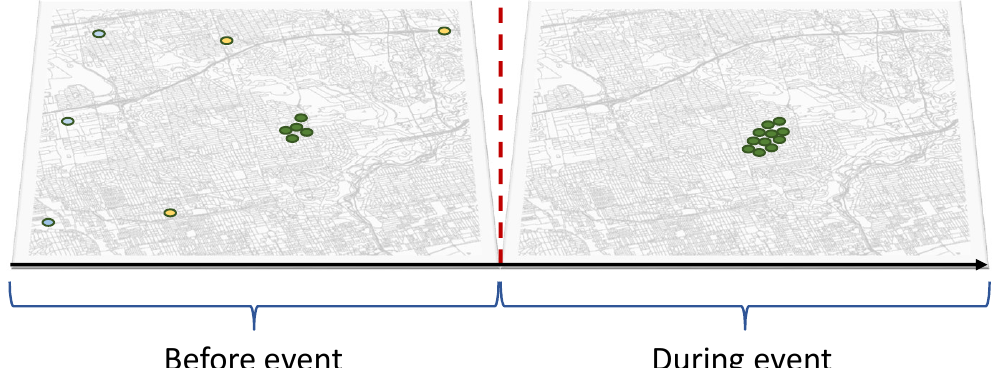
Figure 1. Geospatial-temporal distribution of a psychological crowd before and during an event. The circles refer to the involved individuals. The filled color of circles refers to the temporal pattern of the